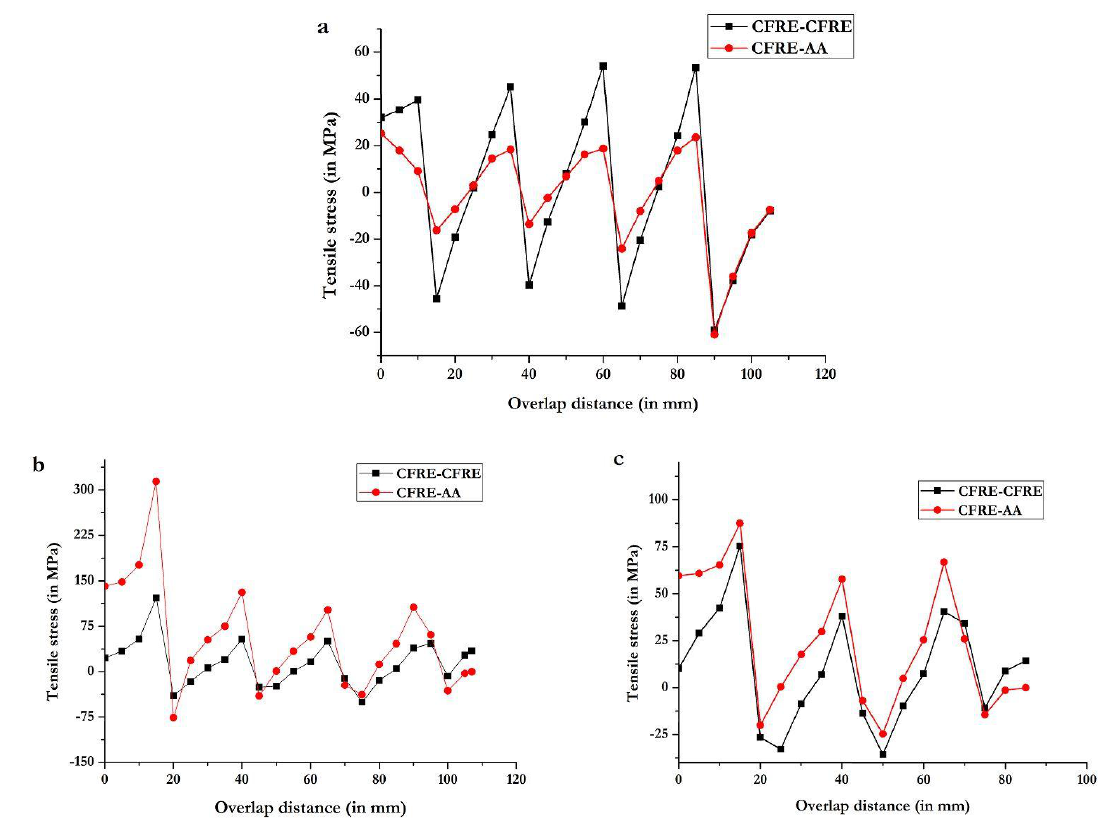
Figure 8. Tensile stress versus the overlap distance for ( a ) substrate, ( b ) doubler 1, and ( c ) doubler 2, for composite-composite and composite-metal riveted joints, at a load of 4.2 kN.